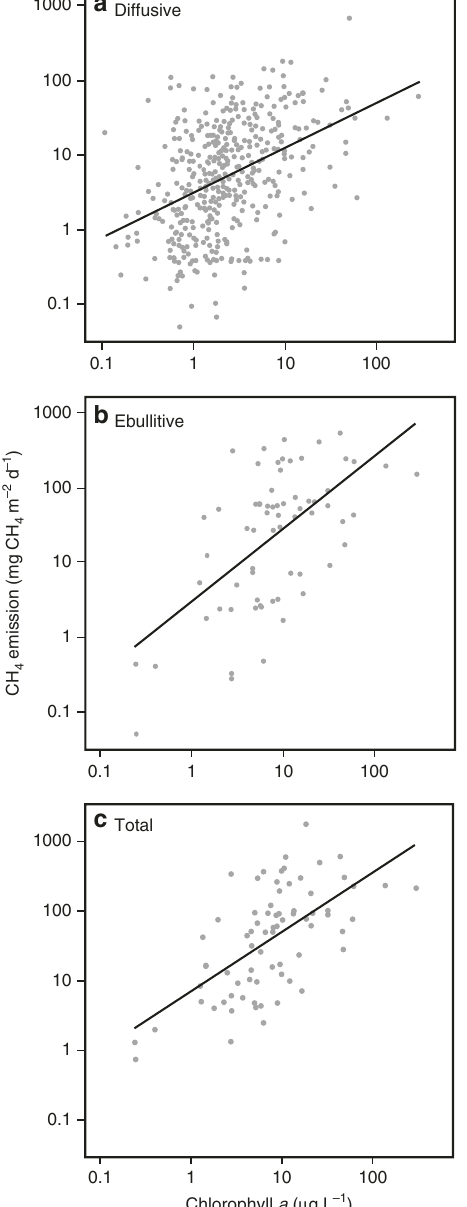
Fig. 1 Relationships between CH 4 fl ux rates and productivity measured as the concentration of chlorophyll a (chla) in the water column of lakes and impoundments. Solid lines are regression relationships. a Diffusive fl ux is the fl ux rate from the water to the atmosphere driven by super-saturation in the water column. b Ebullitive fl ux is that emitted by the formation of bubbles transported to the surface. c Total fl ux is the sum of both diffusive and ebullitive fl ux. Note: panel a shows only the relationship between diffusive CH 4 fl ux and chla concentration, whereas the predictive model for diffusive fl ux includes both a lake size and chla effect (Table 3)